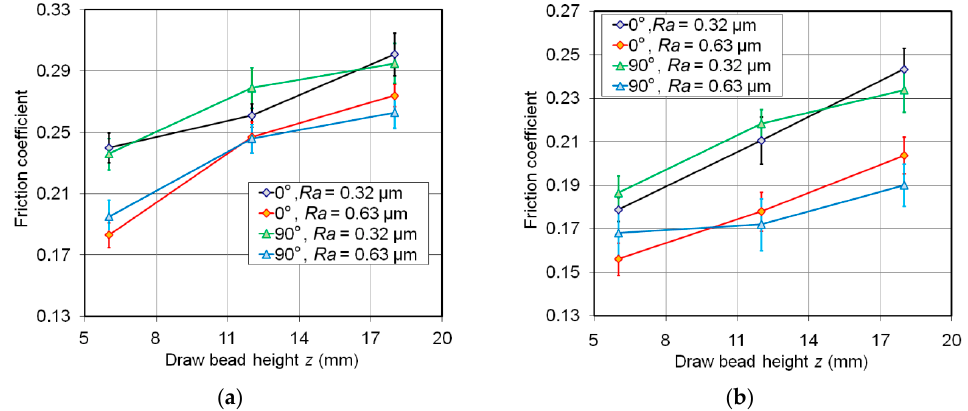
Figure 8. Effect of the draw bead height z on the coefficient of friction for ( a ) dry and ( b ) lubricated conditions.